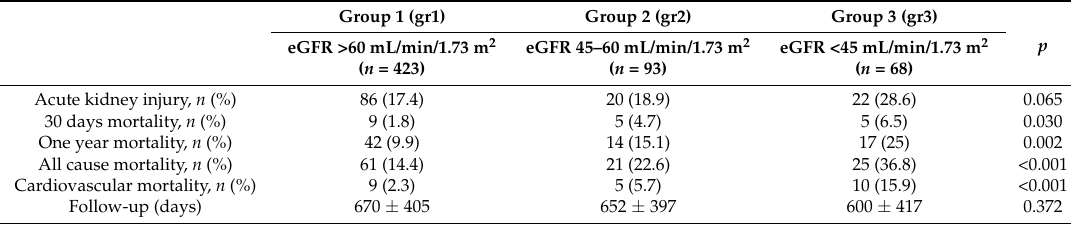
Table 6. Events according to renal dysfunction. 30-day mortality was based on the whole study population (group 1 n = 495, group 2 n = 106, group 3 n =